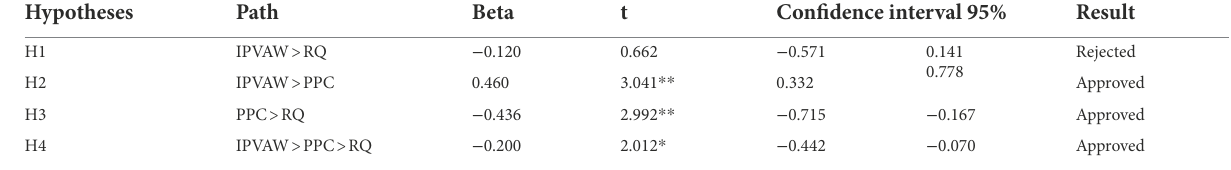
TABLE 5 Hypotheses testing